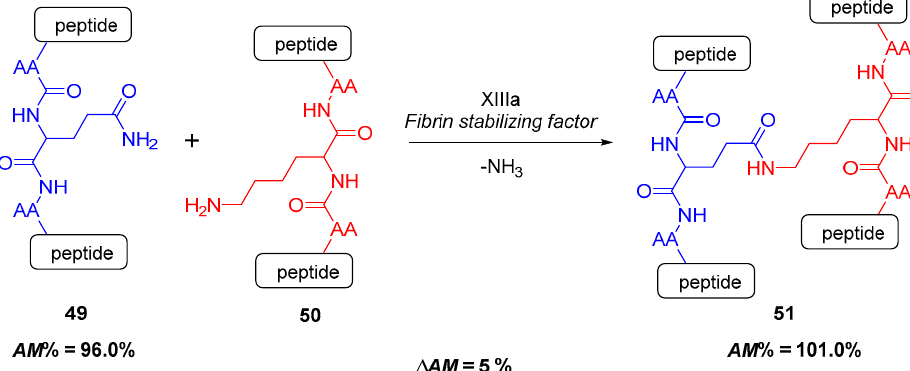
Figure 18. The final step of the blood clotting process from the aspect of amidicity change, catalyzed by the transamidinaze enzyme. The corresponding amidicity values were computed at B3LYP/6-31G(d,p) level of theory.